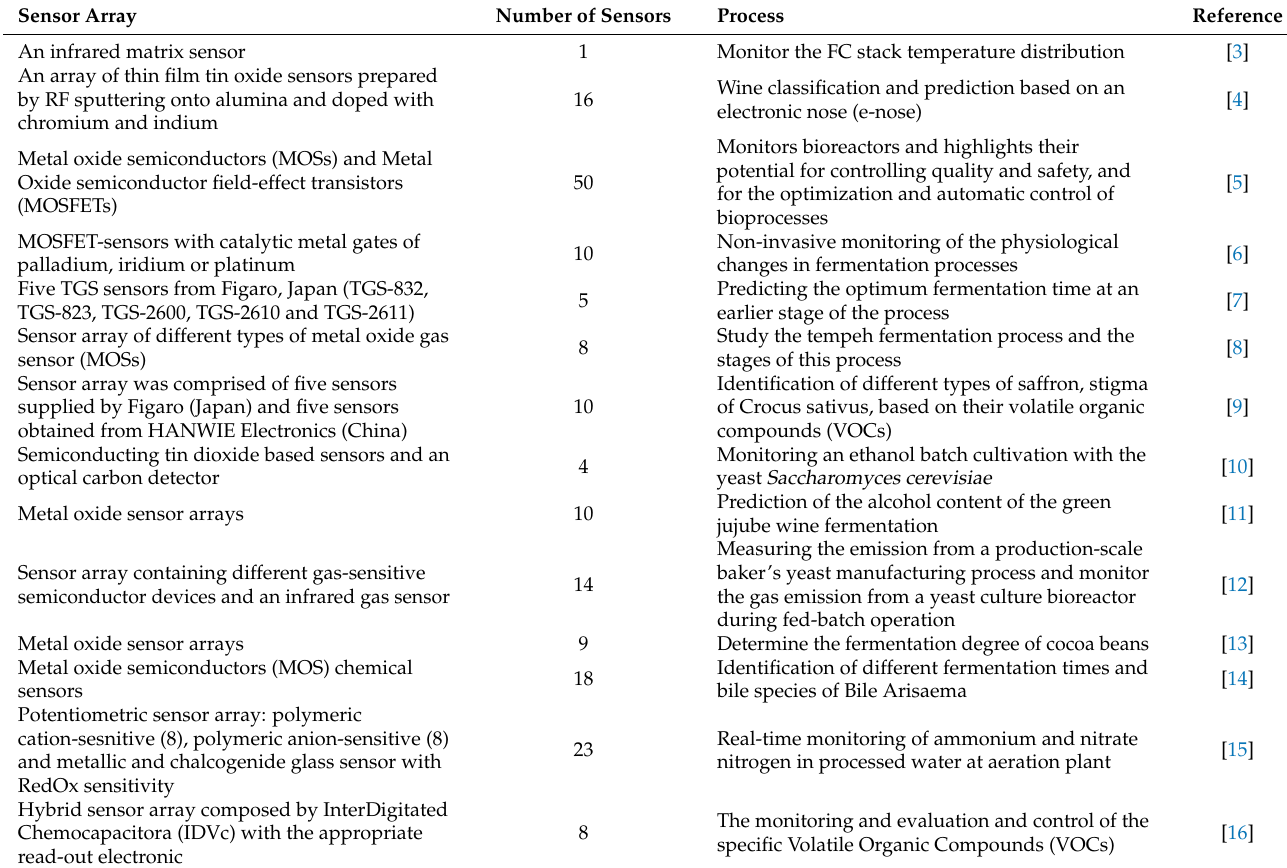
Table 1. Examples of the use of gas sensor arrays to monitor industrial